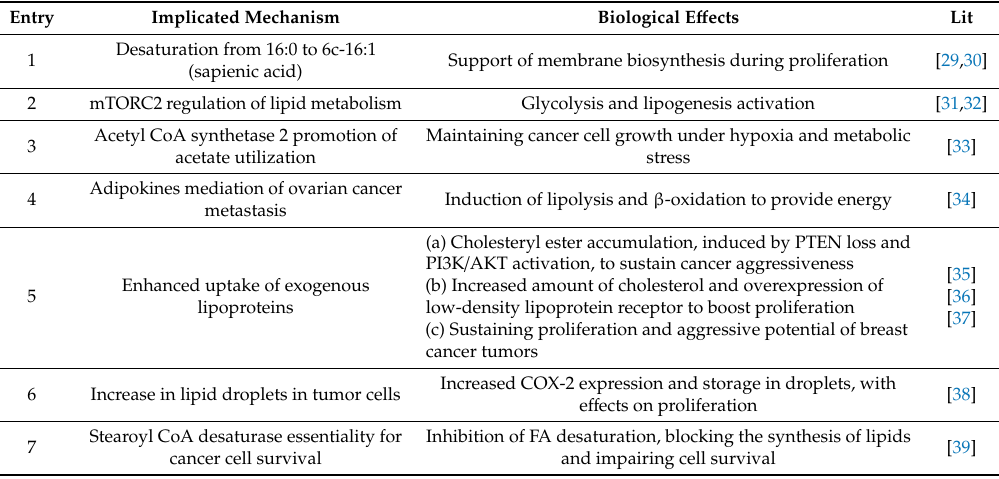
Table 1. The main fatty acid-driven mechanisms and biological effects in cancer onset, growth and metastasis.